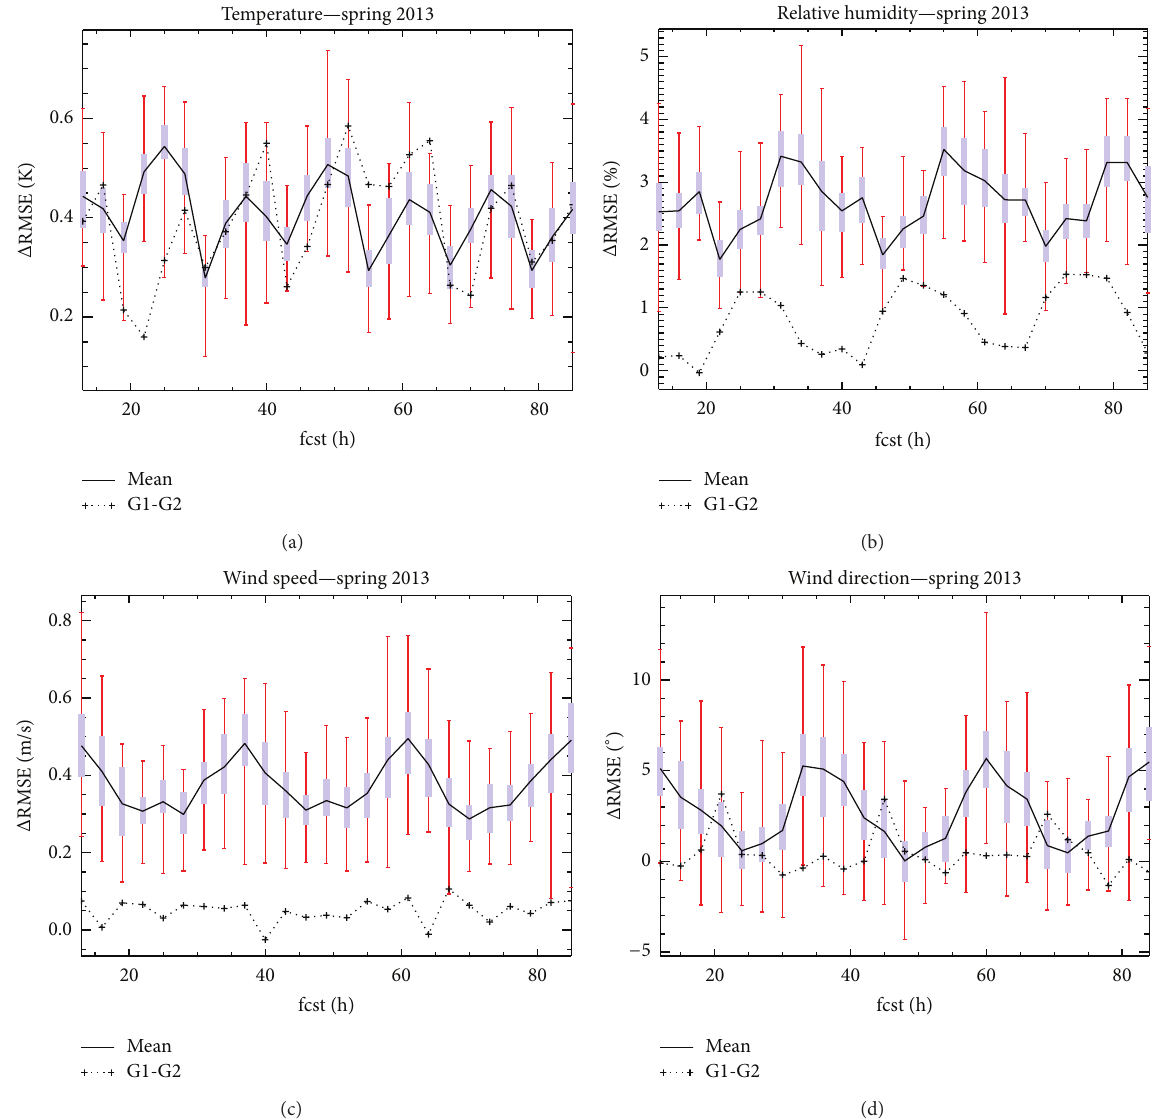
Figure 13: The RMSE difference ( Δ RMSE) between the forecast without and with the application of the MOS for temperature (a), relative humidity (b), wind speed (c), and wind direction (d) for different forecasting times ( 𝑥 - axis). Positive values of Δ RMSE show an improvement of the forecast using MOS. The solid line shows the Δ RMSE averaged over the 50 applications of the MOS. The boxes delimit the 25th and 75th percentile, while the error bar spans between the maximum and minimum values of the 50 applications of the MOS. The dotted line shows the difference between the RMSEs for the model configuration with one grid (12km horizontal resolution) and two nested grids (3km horizontal resolution). A positive value of Δ RMSE represents a better performance for the 3 km horizontal resolution.